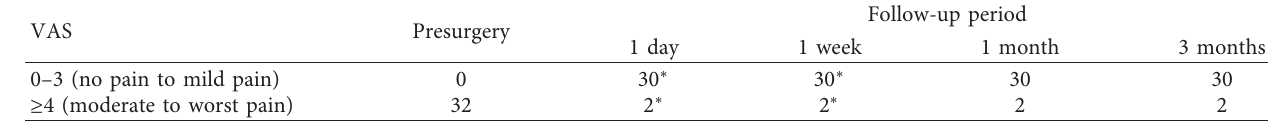
Table 3: Follow-up period and VAS scores ( n � 32).